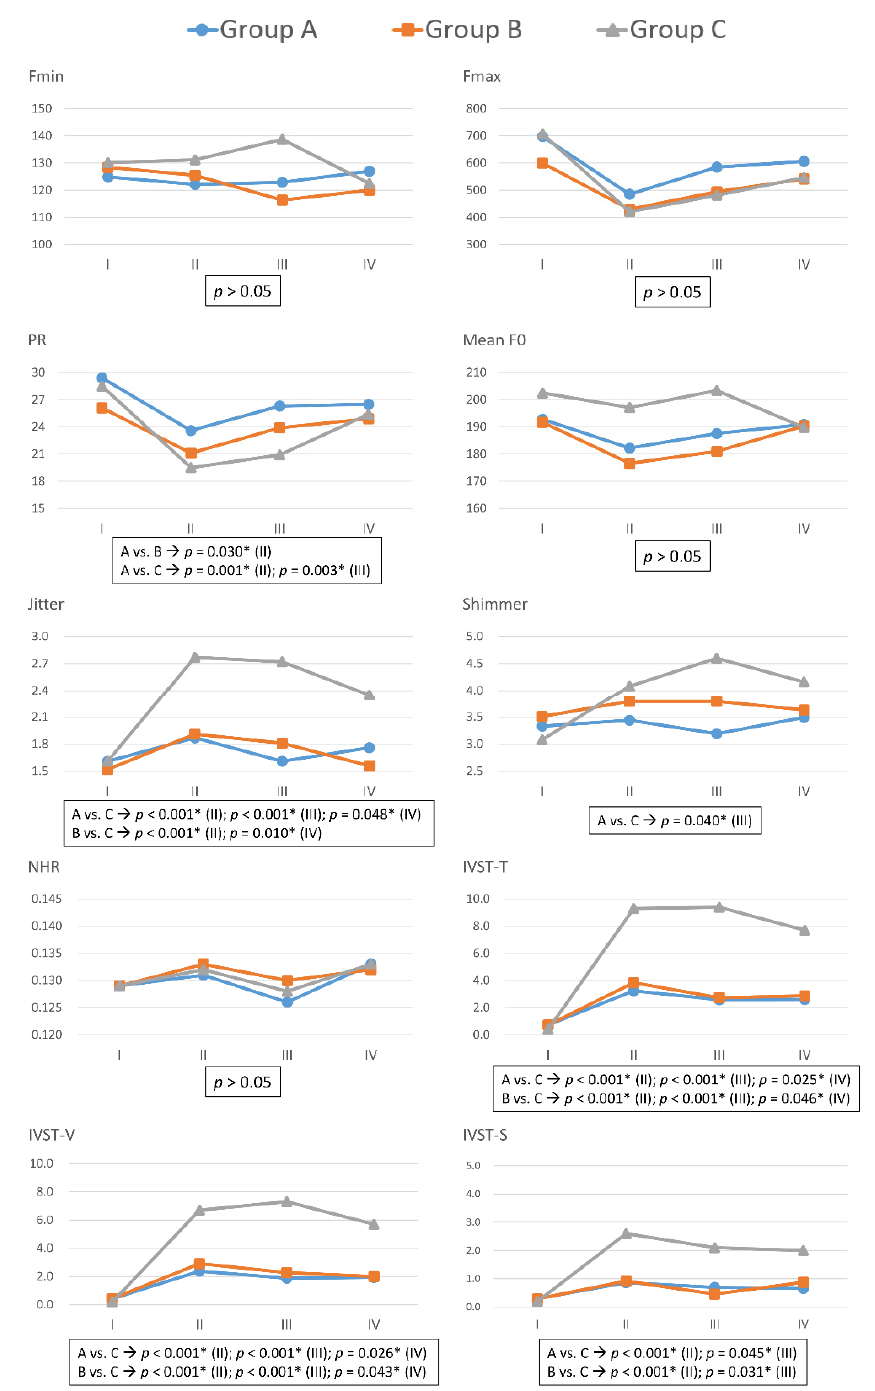
Figure 2. Preoperative and postoperative voice parameters with different severity of recurrent laryngeal nerve dysfunction. In Group A (blue line), B (red line), and C (gray line), post-dissection R2 signals were <50%, 50–90%, and >90% lower than pre-dissection R1 signals, respectively. Fmax = Maximum pitch frequency; Fmin = Minimum pitch frequency; PR = Pitch range; Mean F0 = mean fundamental frequency; NHR = noise-to-harmonic ratio; IVST = Index of Voice and Swallowing Handicap of Thyroidectomy; IVST-T = Total IVST score; IVST-V = IVST score of voice domain score; IVST-S= IVST score of swallowing domain. The units of each voice parameter were as follows: Fmax(Hz), Fmin(Hz), PR(semitone), Jitter(%), Shimmer(%), NHR(value); IVST-T(score); IVST- V(score); IVST-S(score). Period I = Preoperative period (within two months prior to surgery); period II = Immediate postoperative period (median duration of three days; range of one to seven days); period III = Short-term postoperative period (median duration of 12 days; range of seven–30 days);